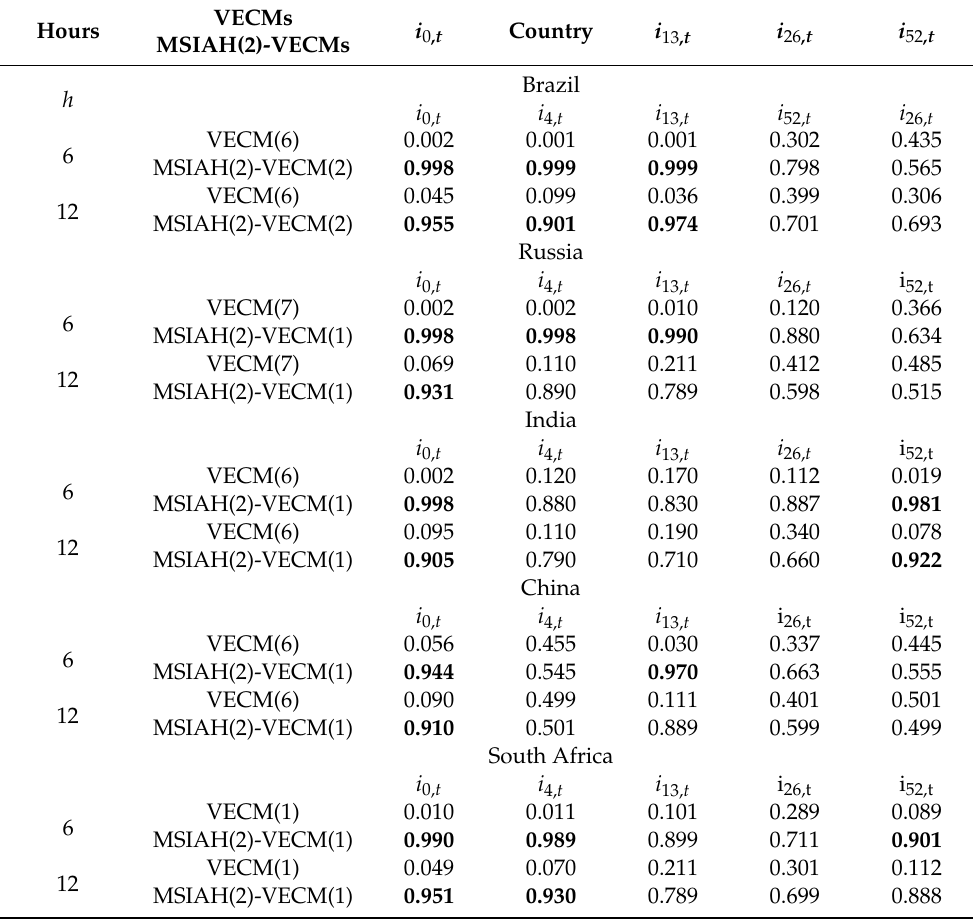
Table 7. Forecasting accuracy-Diebold-Marianno